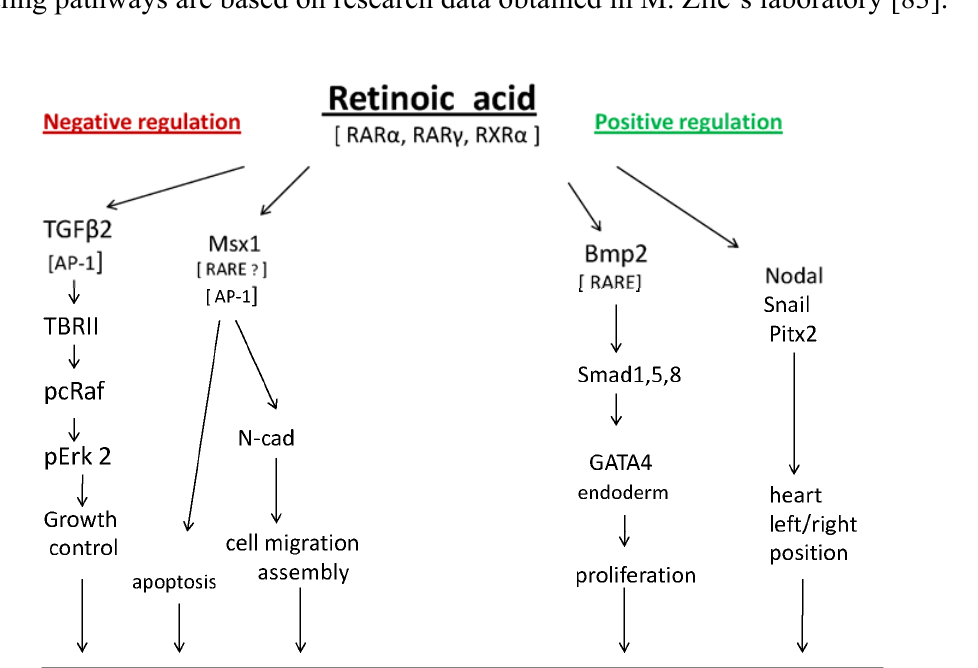
Figure 1. Potential retinoic acid signaling pathways involved in building the early embryonic heart. Retinoic acid (RA) is an embryonic morphogen, participating in heart morphogenesis. The effects of RA are mainly mediated by RA as the ligand for the transcription factors RARs. TGF β 2 [125] and Msx-1 [106,107] both have AP-1 sites in their promoters, that are negatively regulated by RA/RAR blocking AP-1 activity [6,11,125]. Potential binding sites for RAR/RXR have been identified in the Msx1 promoter [105-107]. Genes containing the RA responsive element, RARE, such as Bmp2 [137], are direct RA target genes, regulated by RA/RAR/RXR heterodimers. The potential signaling pathways are based on research data obtained in M. Zile’s laboratory